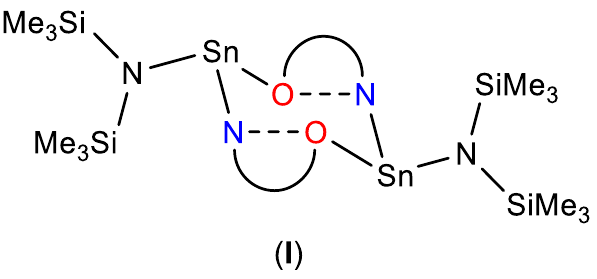
Scheme 5. Schematic drawing showing the coordination of the {hp} ligand in complex 1 .